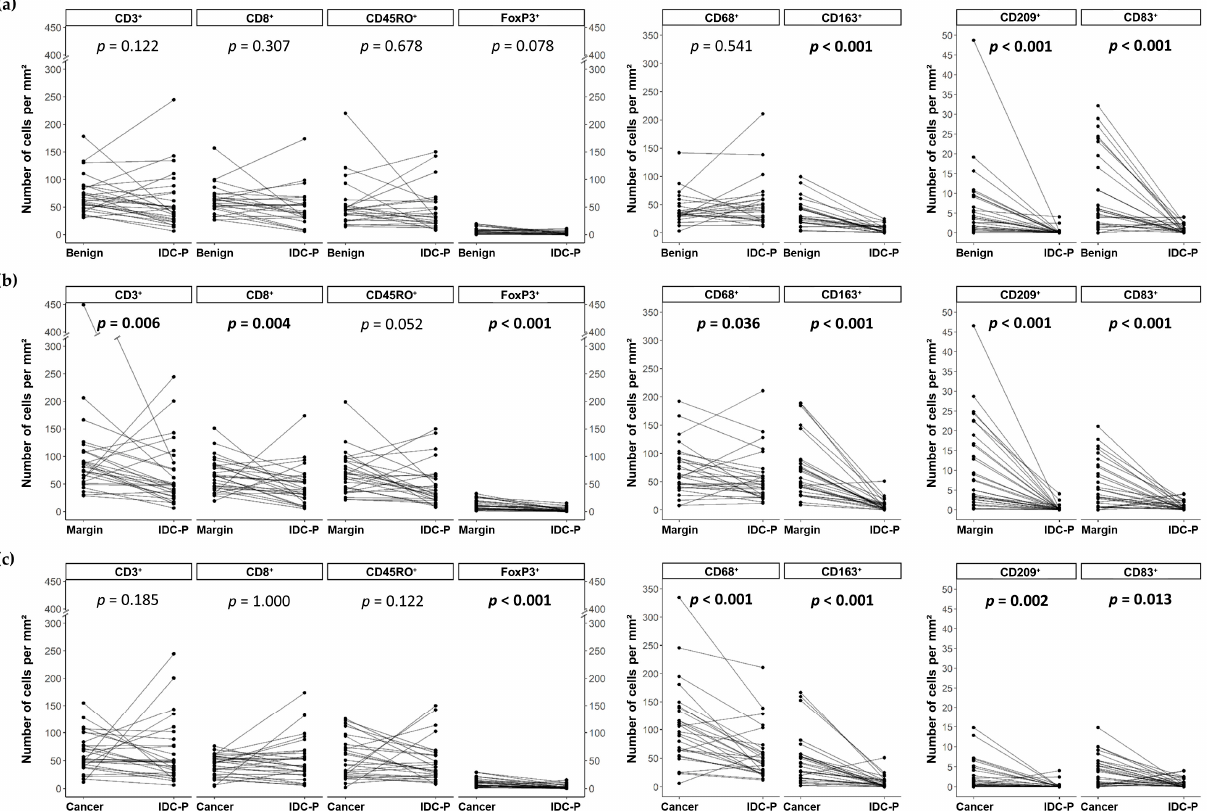
Figure 3. Parallel coordinate plots showing the changes in cell density for each IDC-P-positive pa- tient between the IDC-P compartment and benign tissues ( a ), margins ( b ) and cancer ( c ). Paired- samples sign tests were performed. Bold entities indicate statistically significant p -values. IDC-P: intraductal carcinoma of the prostate.